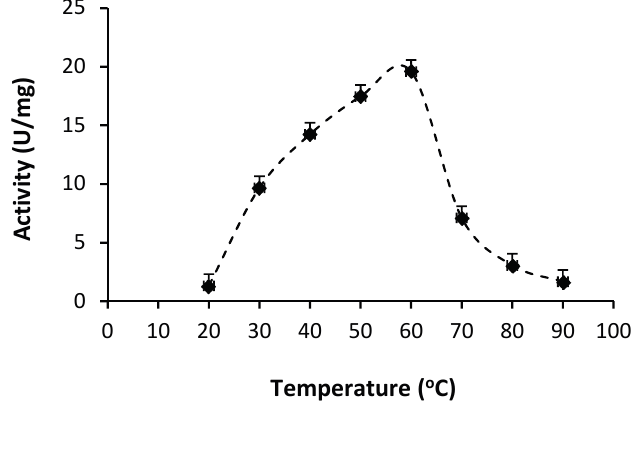
Figure 3. Effect of temperature on activity of Bentong ginger protease.